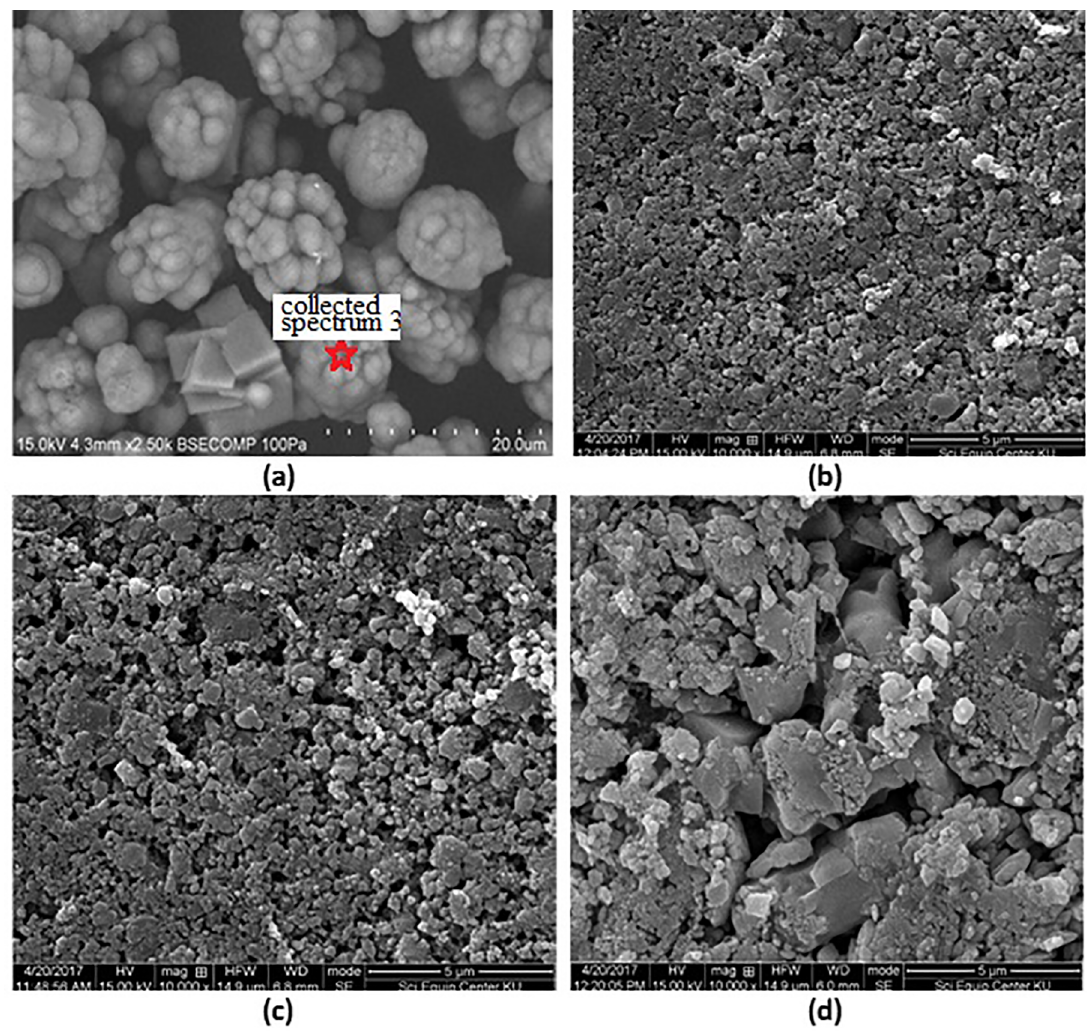
surface, temperature influence on the CaCO morphologies; (a) at the reaction temperature of Figure 5. The SEM micrographs of CaCO 3 3 60°C, (b) at the annealing temperature of 350°C, (c) at the annealing temperature of 400°C, and (d) at the annealing temperature of 450°C